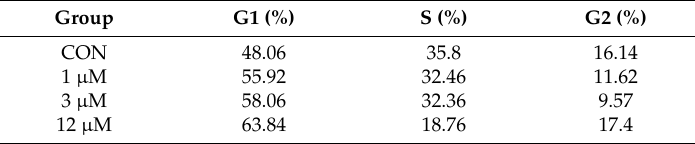
Table 4. Compound 4 effect on HepG2 cell cycle of human.